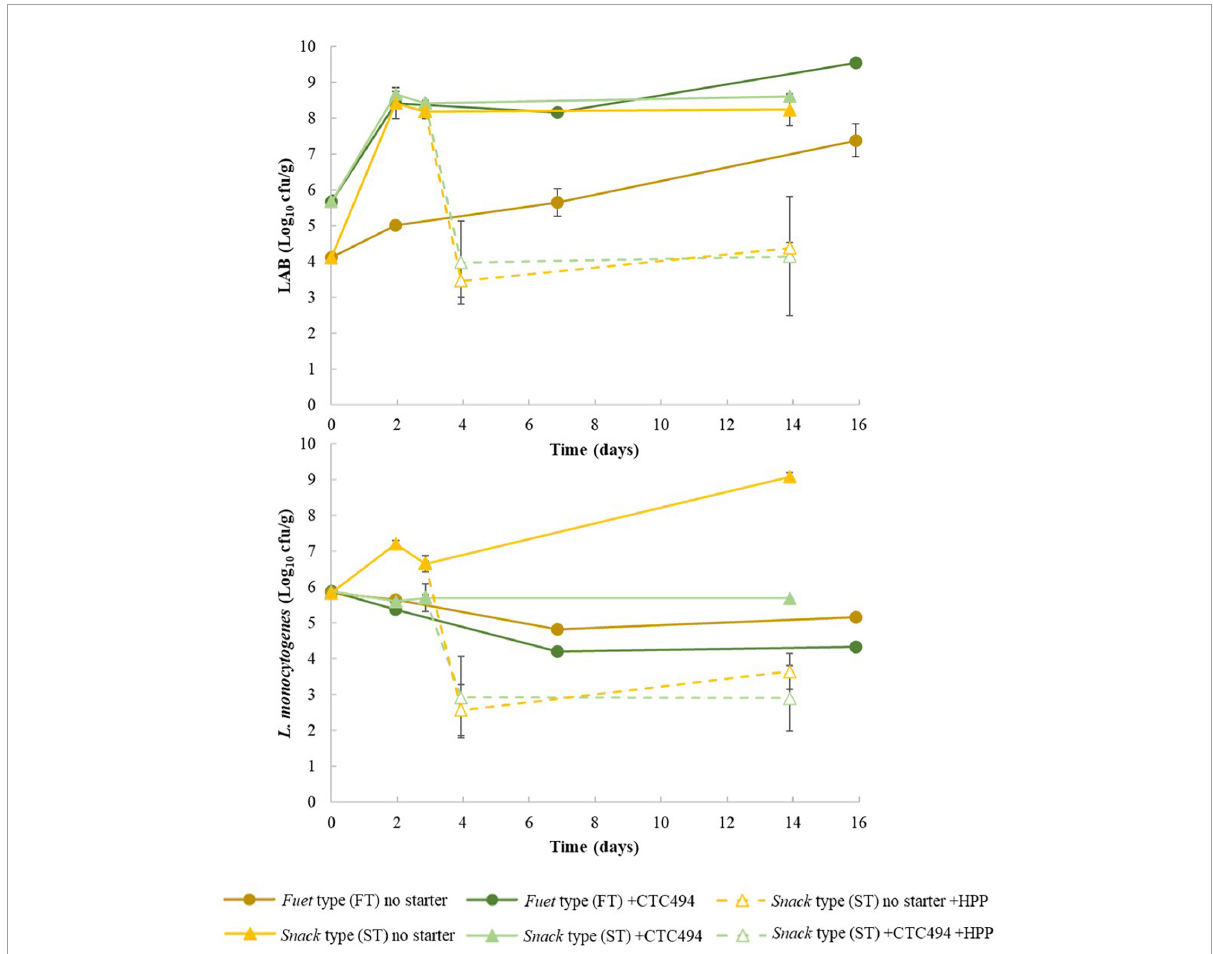
FIGURE3 Counts of lactic acid bacteria (LAB) and L. monocytogenes during the fermentation and ripening of fuet -type (FT) and snack-type (ST) sausages spontaneously fermented (no starter) and with the addition of the bioprotective (sakacin K)-producing L. sakei CTC494. Error bars correspond to standard deviation of the mean